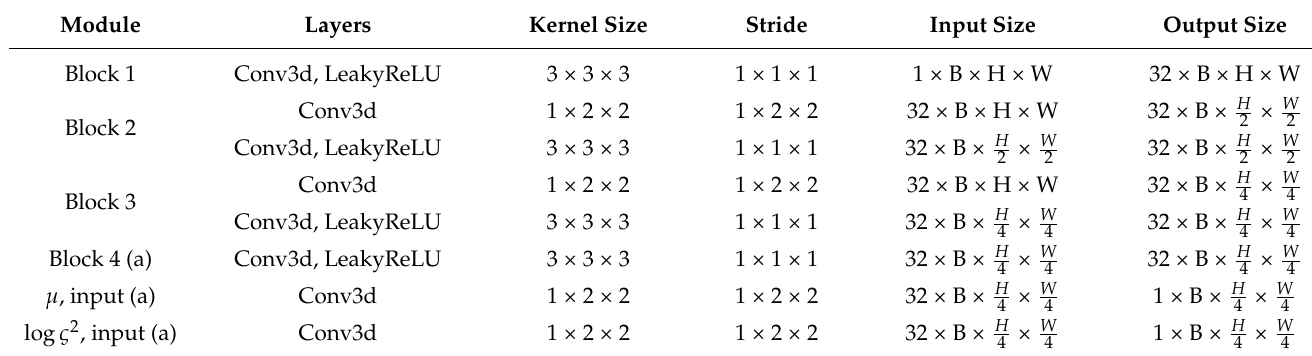
Table 3. Network configuration of the encoder.